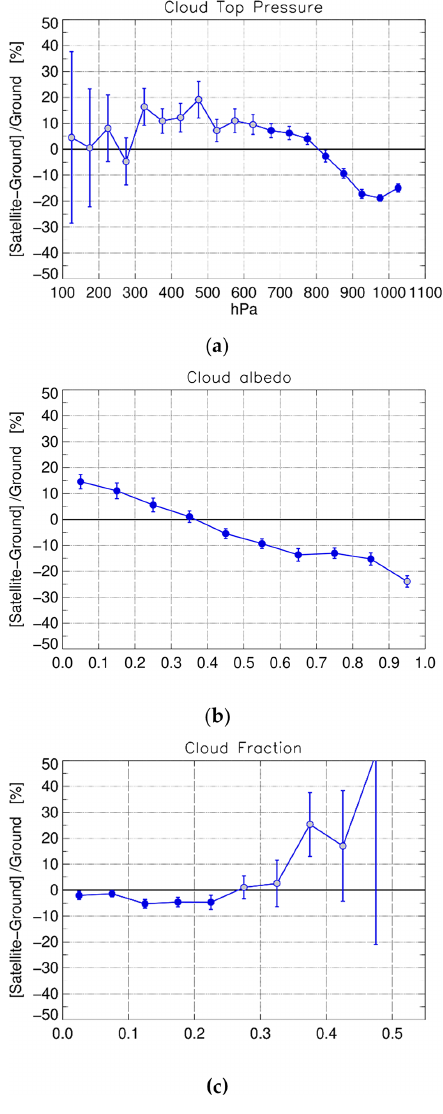
Figure 11. The dependency of the comparisons of satellite- to ground-based TCWV measurements on three different cloud pa- rameters, namely (a) cloud top pressure, (b) cloud albedo and (c) cloud fraction. The error bars show the standard error of the mean with a confidence interval (CI) of 99.7%. Grey dots represent bins containing < 3% of the total co-location pairs.